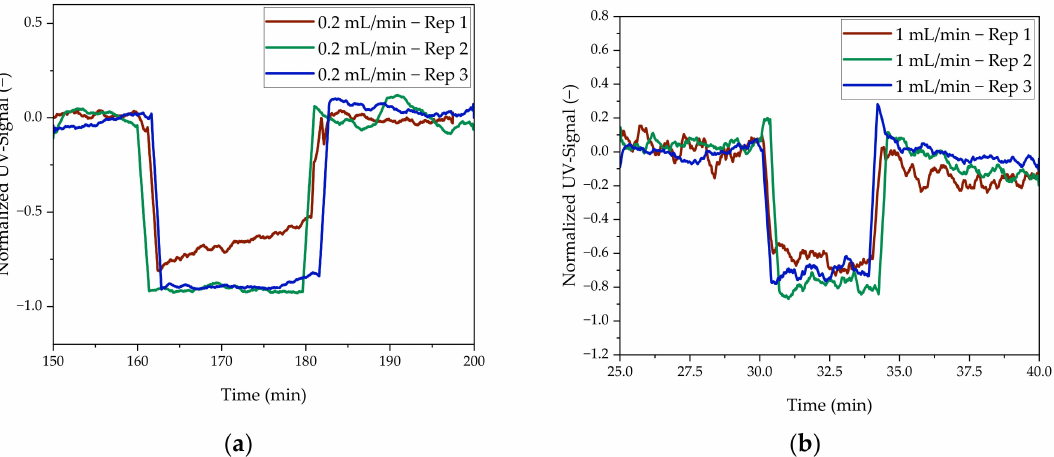
Figure 11. Normalized output signal of the slug. Recorded with a UV detector at a volume flow of ( a ) 0.2 mL/min and ( b ) 1 mL/min.